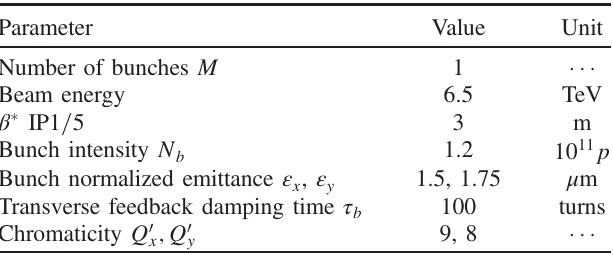
FIG. 9. Horizontal (red) and vertical (blue) fractional tunes as a function of time for each of the j C − j measurements. The left plot was a measurement of the machine with well corrected coupling, and the right plot shows the coupling after the knobs were varied. The white dashed lines are used to compute the closest